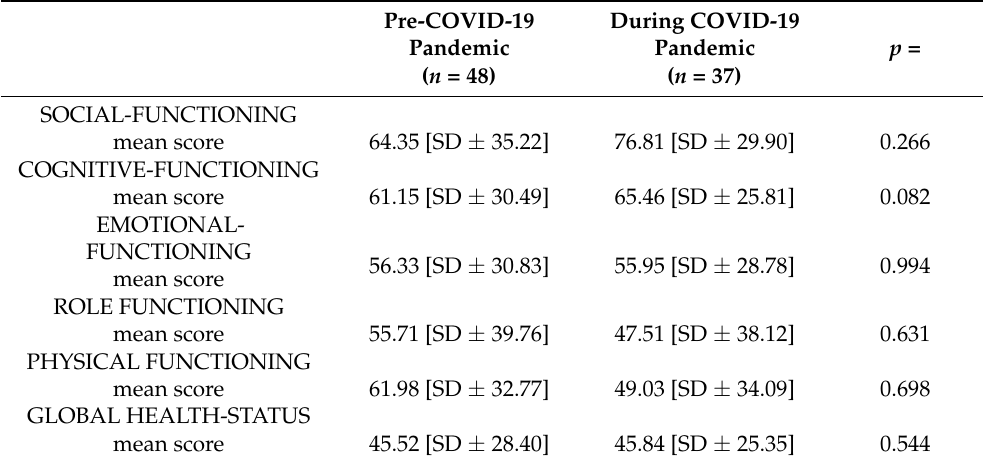
Table 2. Results from the EORTC QLQ-C30-BN20 questionnaire. Neither of the analysed items reached significance when mean scores of pre-COVID and during COVID screening were compared. However, in group B we only had 37 of 62 datasets available, which might limit confidence of